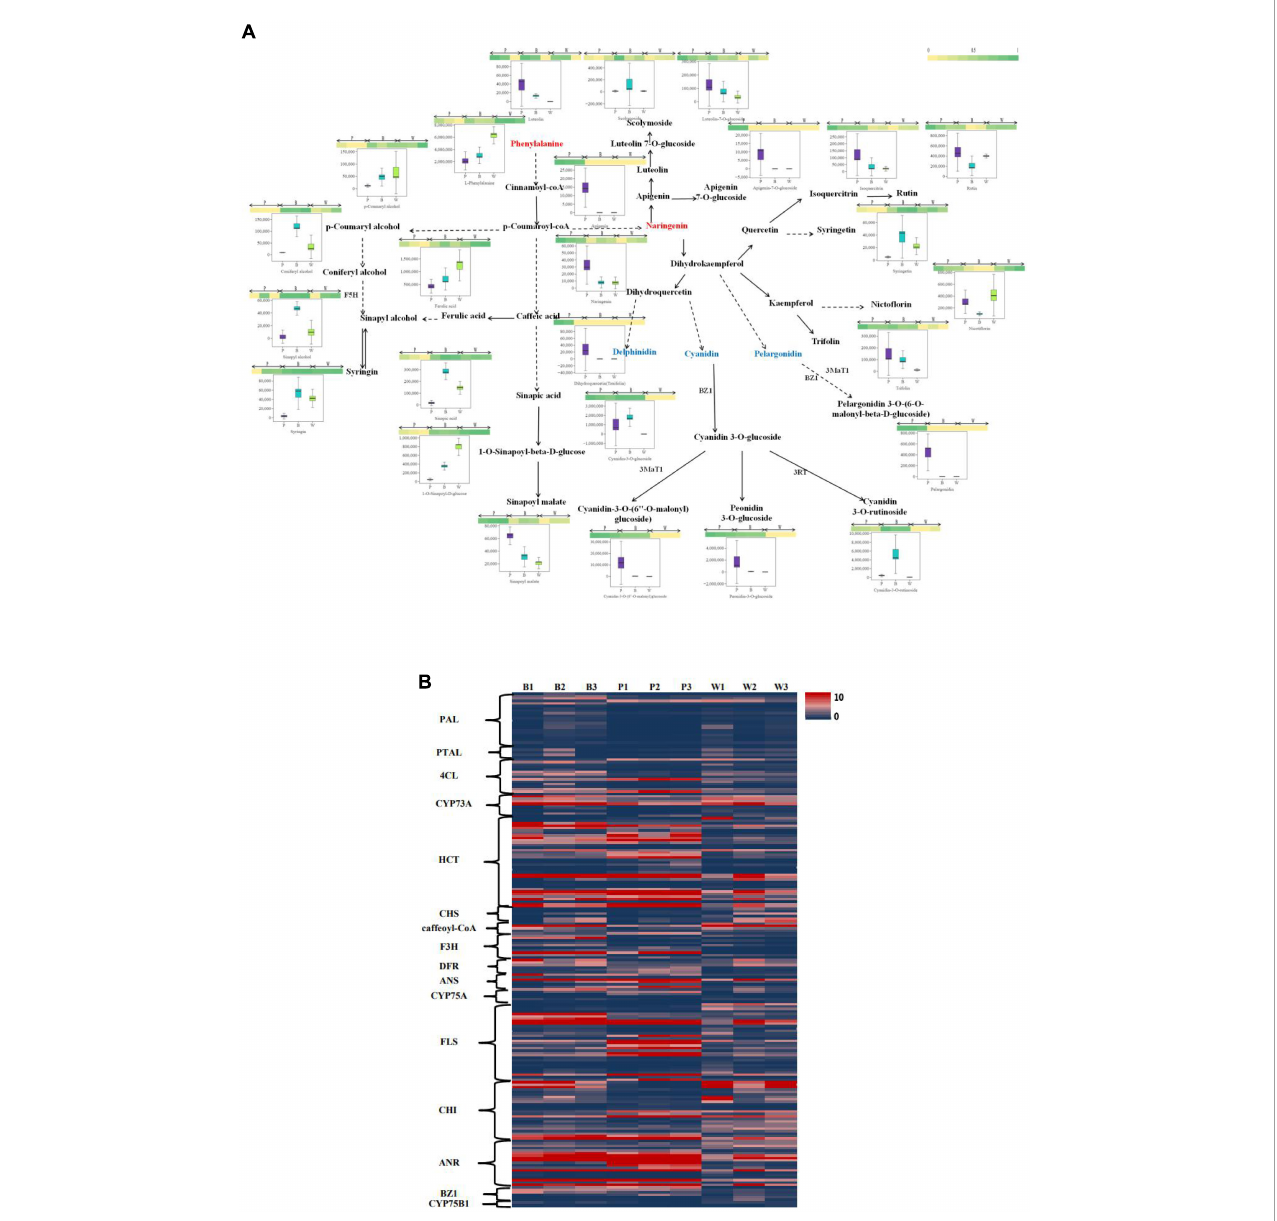
FIGURE5 (A) Heat map of metabolites of the wheat seed color synthesis pathway. The pathway was constructed based on the KEGG pathway and the scientific literature. Each colored box indicates the normalized intensity of each complex ion. Box-and-whisker plots show the variation of color formation-related metabolites in each wheat variety, with the upper and lower ends representing the maximum and minimum values of metabolites, respectively (Three biological replicates × three lines, n = 9). (B) Heat map of gene expression levels (FPKM values) of key enzyme sites of the color formation pathway. PAL, phenylalanine ammonia lyase; PTAL, phenylalanine/tyrosine ammonia-lyase; 4CL, 4-coumarate-CoA ligase; CYP73A, trans -cinnamate 4-monooxygenase; HCT, shikimate O-hydroxycinnamoyltransferase; CHS, chalcone synthase; F3H, naringenin 3-dioxygenase; DFR, bifunctional dihydroflavonol 4-reductase/flavanone 4-reductase; ANS, anthocyanidin synthase; CYP75A, flavonoid 3 (cid:48) ,5 (cid:48) -hydroxylase; FLS: flavonol synthase; CHI, chalcone isomerase; ANR, anthocyanidin reductase; CYP75B1, flavonoid 3 (cid:48) -monooxygenase; BZ1, anthocyanidin